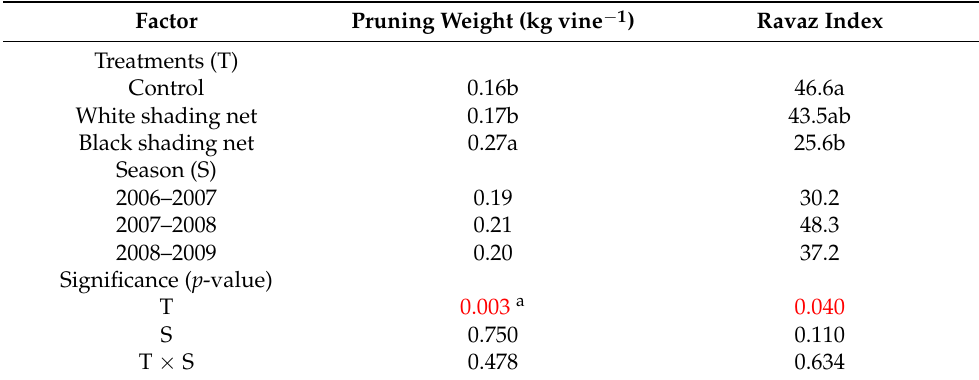
Table 4. Analysis of pruning weight and Ravaz index by shading net treatments and control in